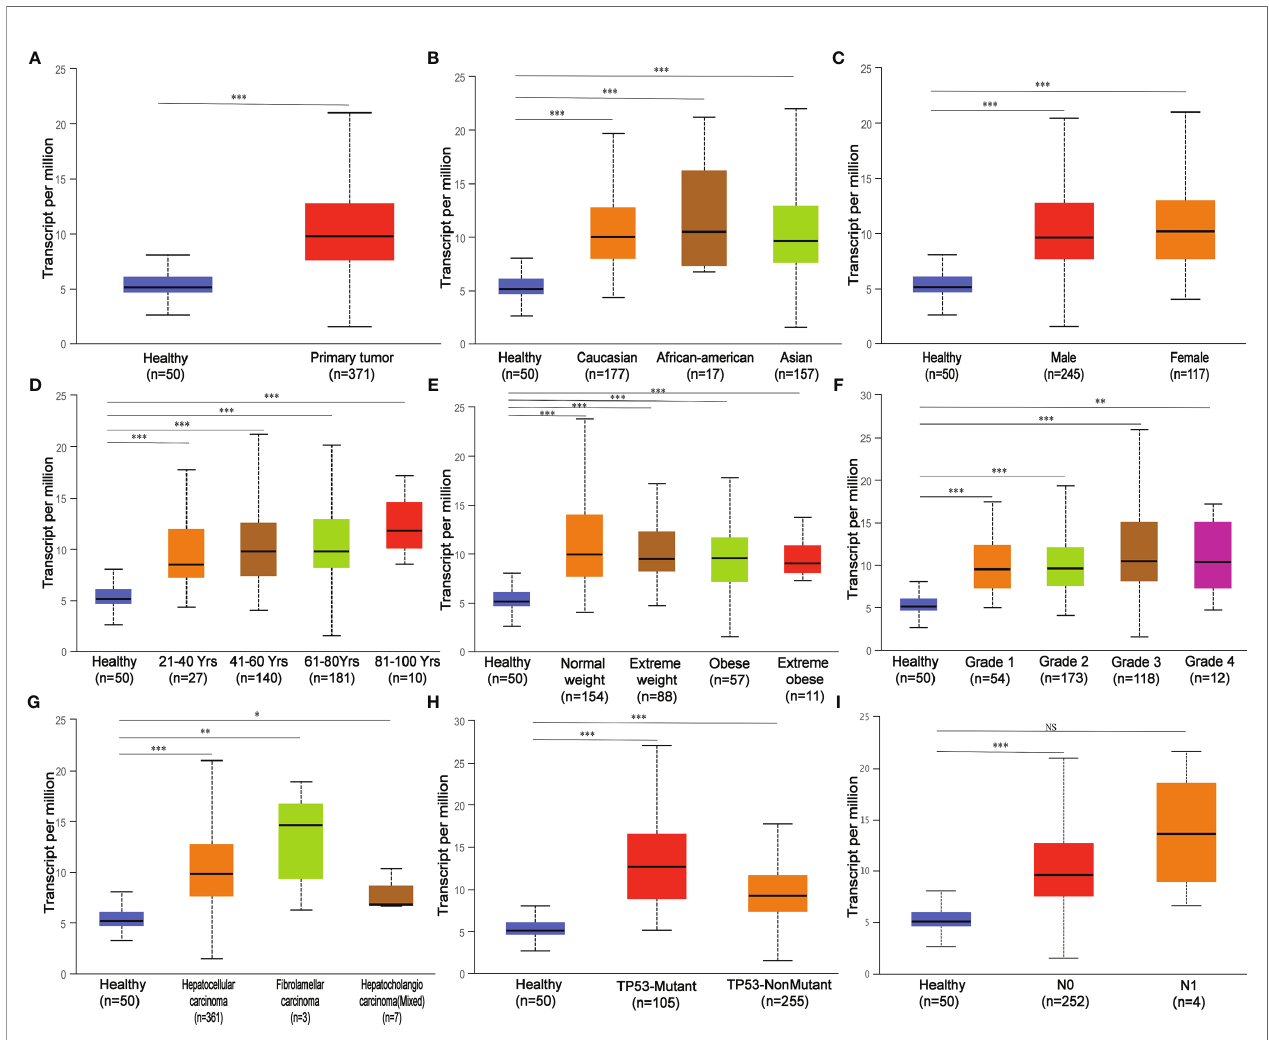
FIGURE 2 | MED19 transcription in subgroups of patients with hepatocellular carcinoma strati fi ed based on gender, age, and other criteria. (A) Boxplot showing relative expression of MED19 in healthy and LIHC samples. (B) Boxplot showing relative expression of MED19 in healthy individuals of any ethnicity or LIHC patients of Caucasian, African-American or Asian ethnicity. (C) Boxplot showing relative expression of MED19 in healthy individuals of either gender or male or female LIHC patients. (D) Boxplot showing relative expression of MED19 in healthy individuals of any age or LIHC patients aged 21-40, 40-60, 61-80, or 81-100 yr. (E) Boxplot showing relative expression of MED19 in healthy individuals of any weight or LIHC patients weighted normal, extreme, obese, or extreme obese. (F) Boxplot showing relative expression of MED19 in healthy individuals or LIHC patients with grade 1, 2, 3 or 4 tumors. (G) Boxplot showing relative expression of MED19 in healthy individuals or LIHC patients of hepatocellular carcinoma, fi brolamellar carcinoma, or hepatocholangio carcinoma (mixed). (H) Boxplot showing relative expression of MED19 in healthy individuals or LIHC patients with TP53 -mutant or TP53 - nonmutant. (I) Boxplot showing relative expression of MED19 in healthy individuals or LIHC patients with no regional lymph node metastasis or metastases in 1 to 3 axillary lymph nodes. * P < 0.05; ** P < 0.01; *** P < 0.001; NS, nonsigni fi